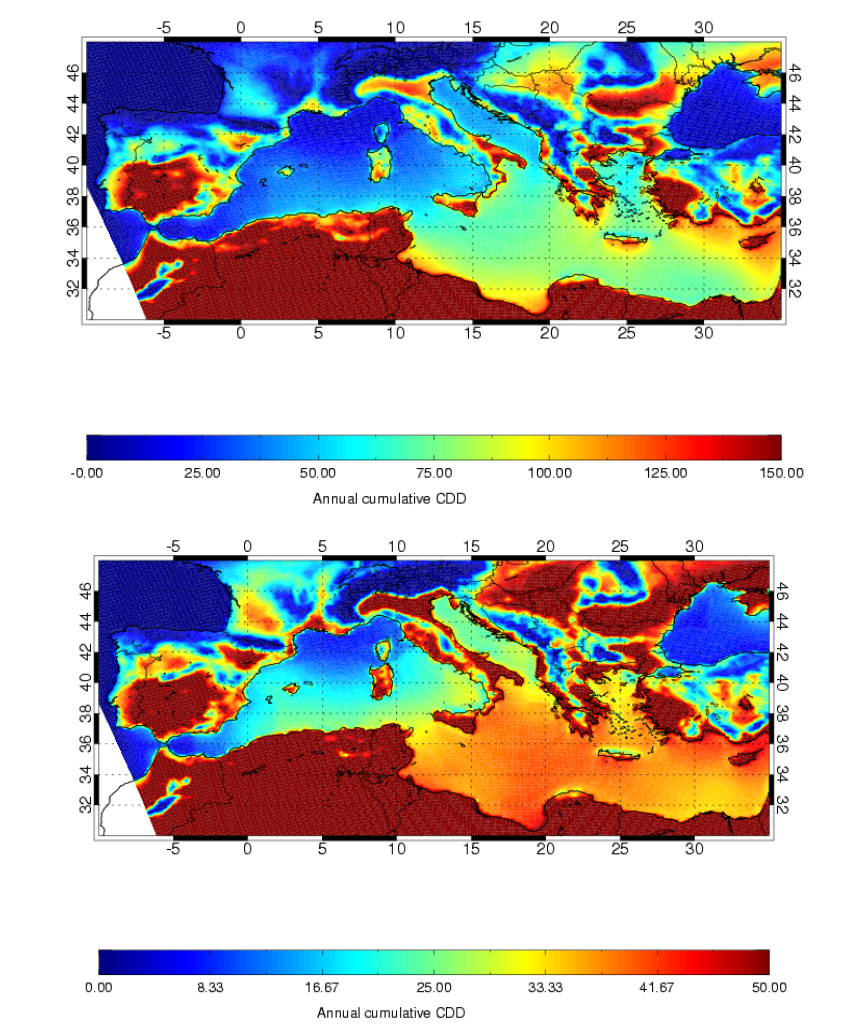
Figure 2. Changes in annual cumulative CDD between future and control period (top) and standard deviation of the changes